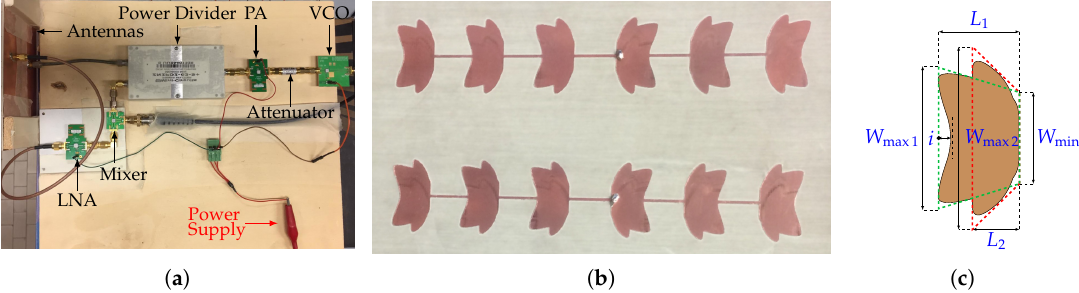
Figure 3. Photo of ( a ) the radar system, ( b ) the antennas, and ( c ) the geometry of the